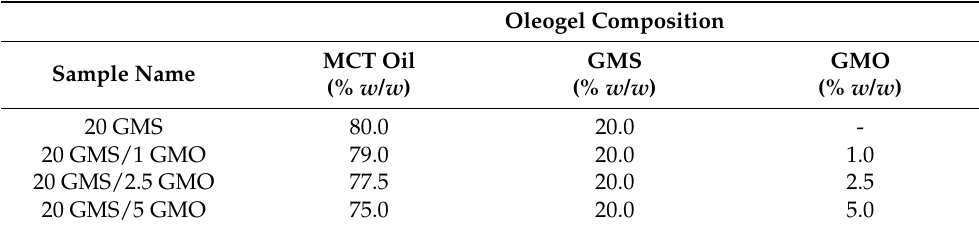
Table 1. Compositions of different oleogel